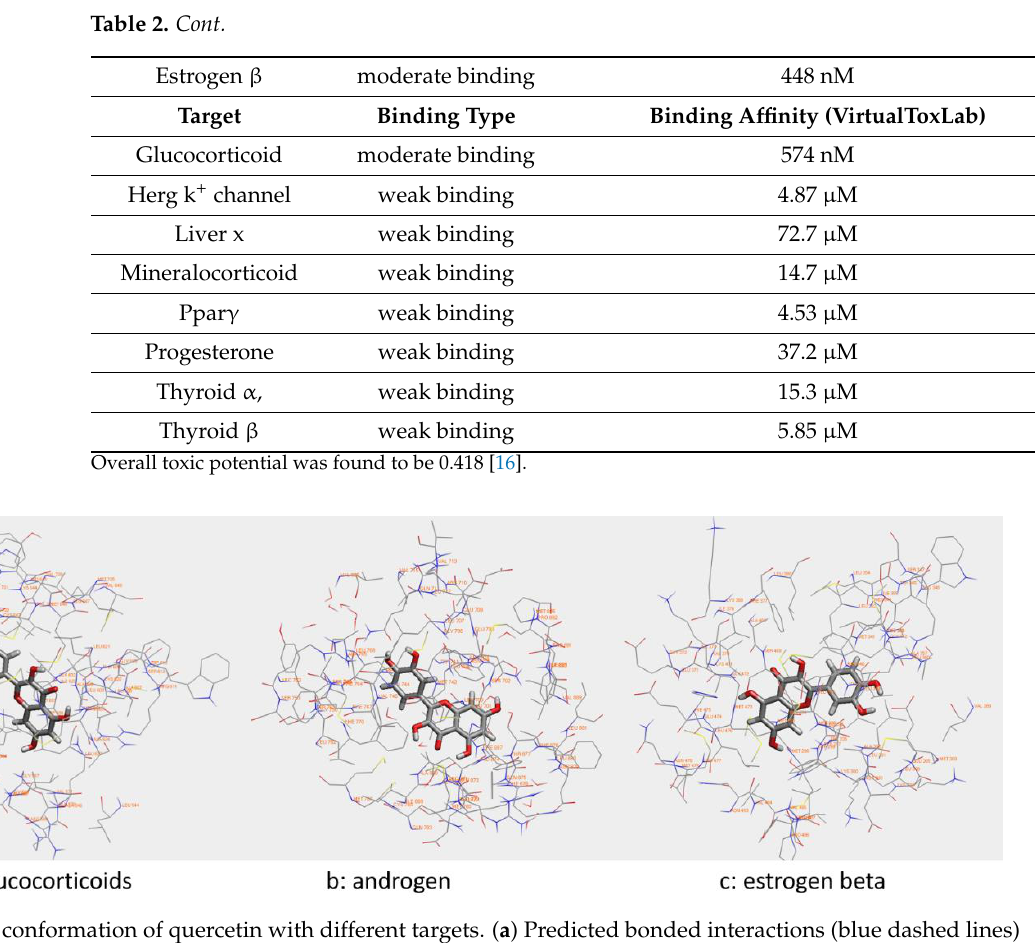
Figure 3. Docking conformation of quercetin with different targets. ( a ) Predicted bonded interactions (blue dashed lines) between quercetin and glucocorticoid; ( b ) binding interaction between quercetin and androgen; ( c ) binding interaction of quercetin and estrogen alpha. The ligand is based on atom type and the protein-based on amino acid residue type coloring.